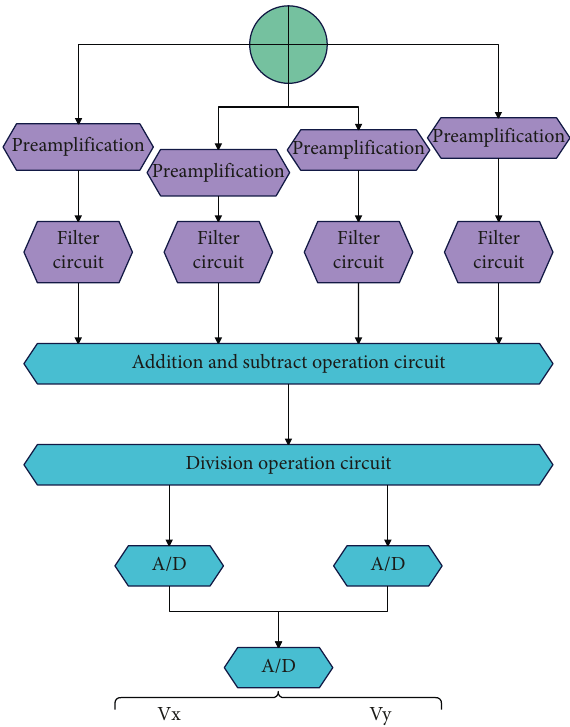
Figure 5: Four-quadrant detector system